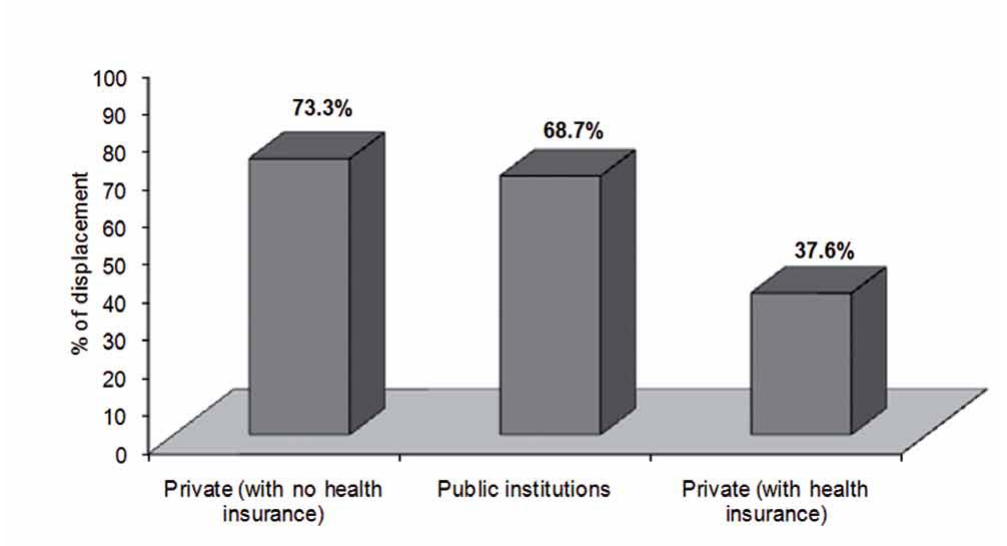
Figure 2 - Need of displacement from the city of residence, according to the health-care